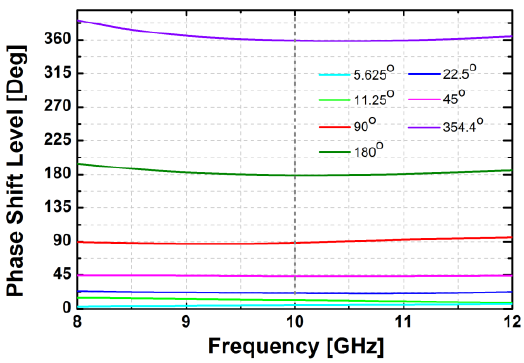
Figure 7. Simulated relative phase shift levels in the main states of the phase shifter block.